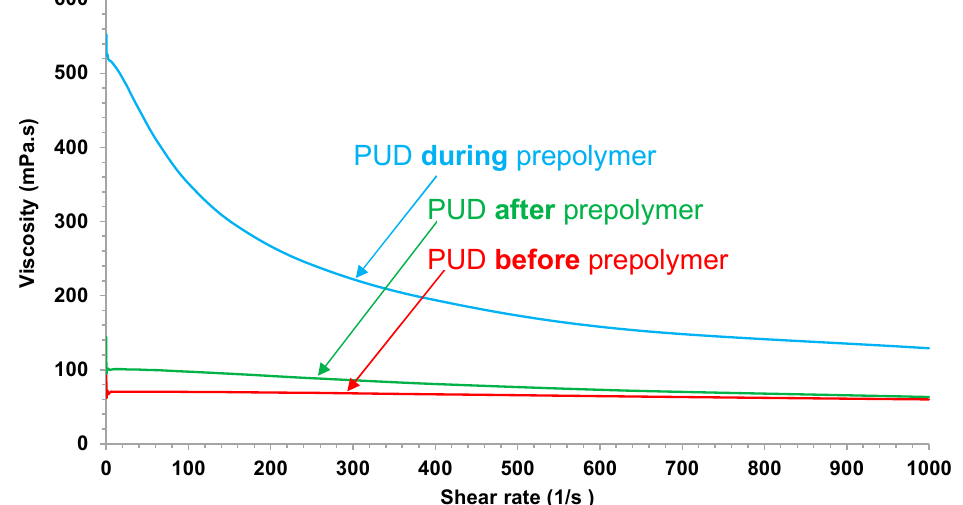
Figure 7. Variation of the viscosity at 25 °C of the PUDs as a function of the shear rate. Coaxial cylindrical geometry experiments.